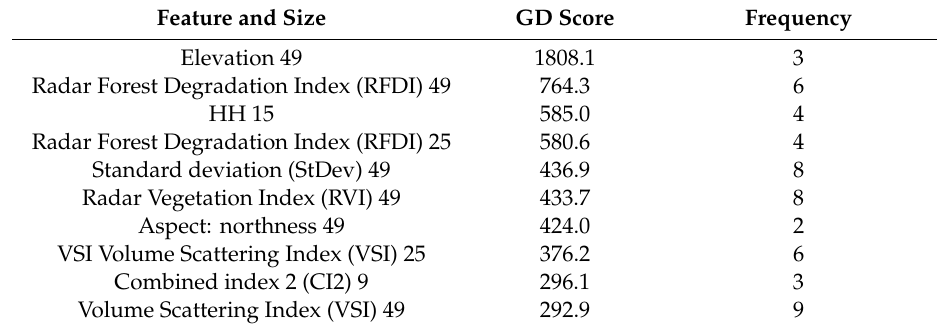
Table 7. Features with the highest average Gini decrease throughout all classifications. GD = Gini